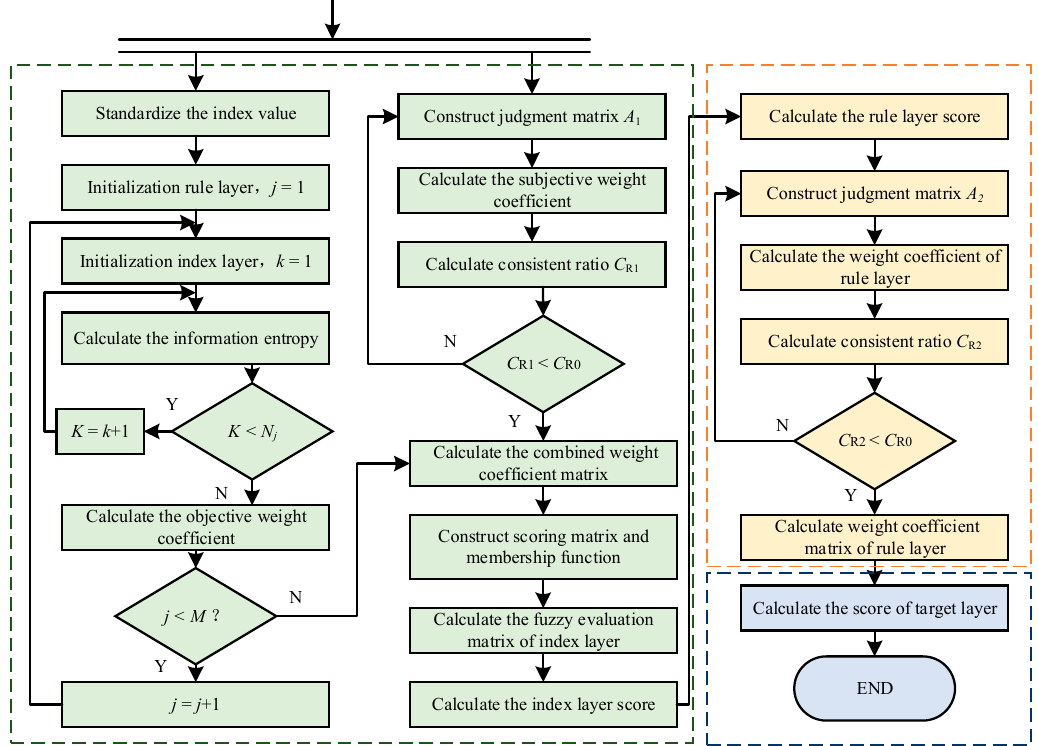
Figure 3. The comprehensive framework. Figure 3. The comprehensive framework. Equation (13) is the standardized formula for positive indexes and Equation (14) is the standardized formula for negative indexes. Where j is the index of the rule layer; m is the index of the index layer; k is the index of the indexes; y jmk is the standardized index value; x jmk is the index value before standardization; x jm is the minimum value of x jmk ; and x jm max min is the maximum value of x jmk